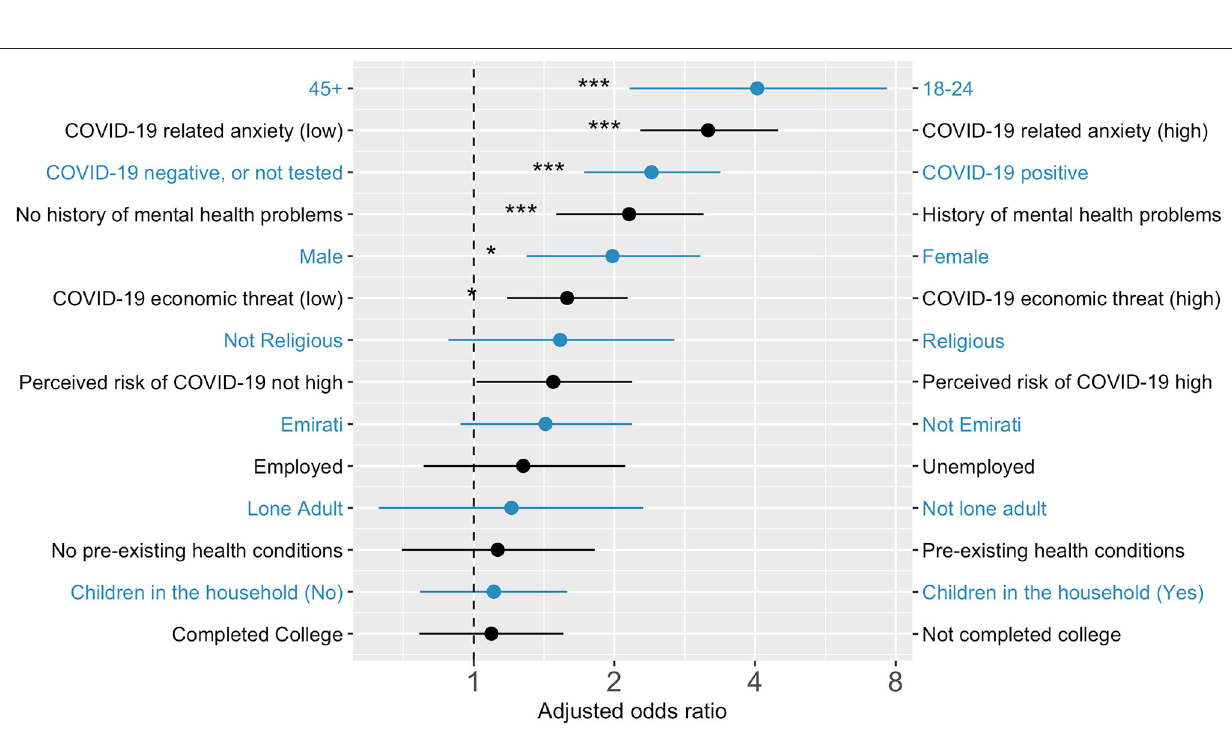
Frontiers in Psychiatry |